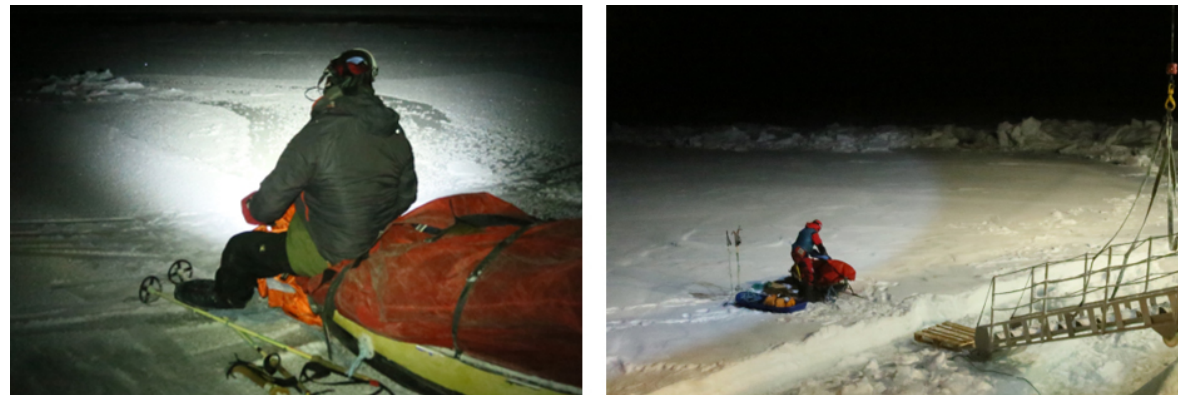
Figure 4. Example photographs of young ice witnessed in the N-ICE2015 campaign within the study area (photos: P. Itkin).